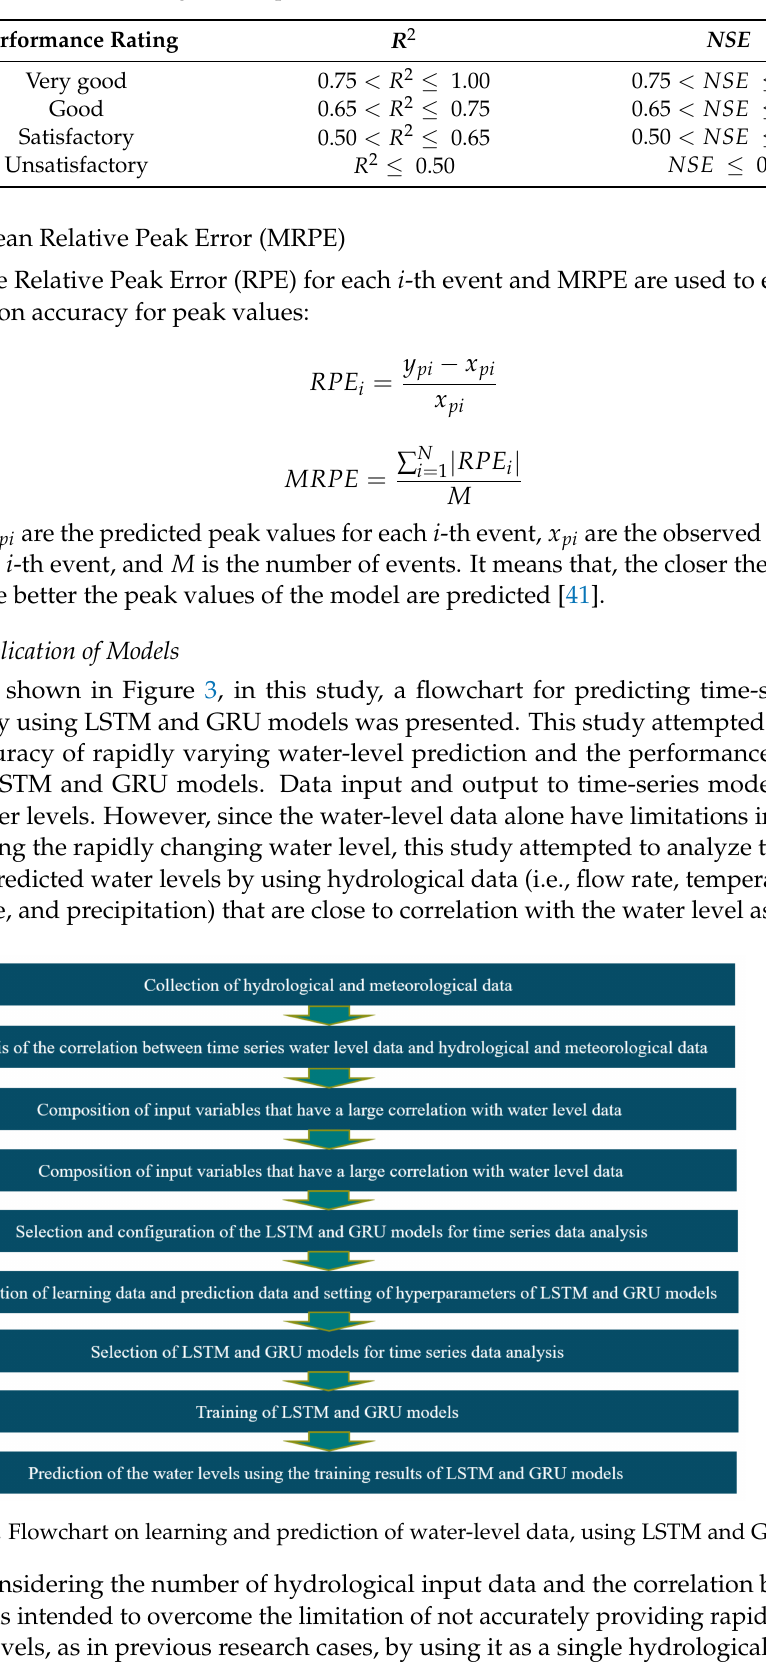
Table 1. Performance ratings for adopted statistics.